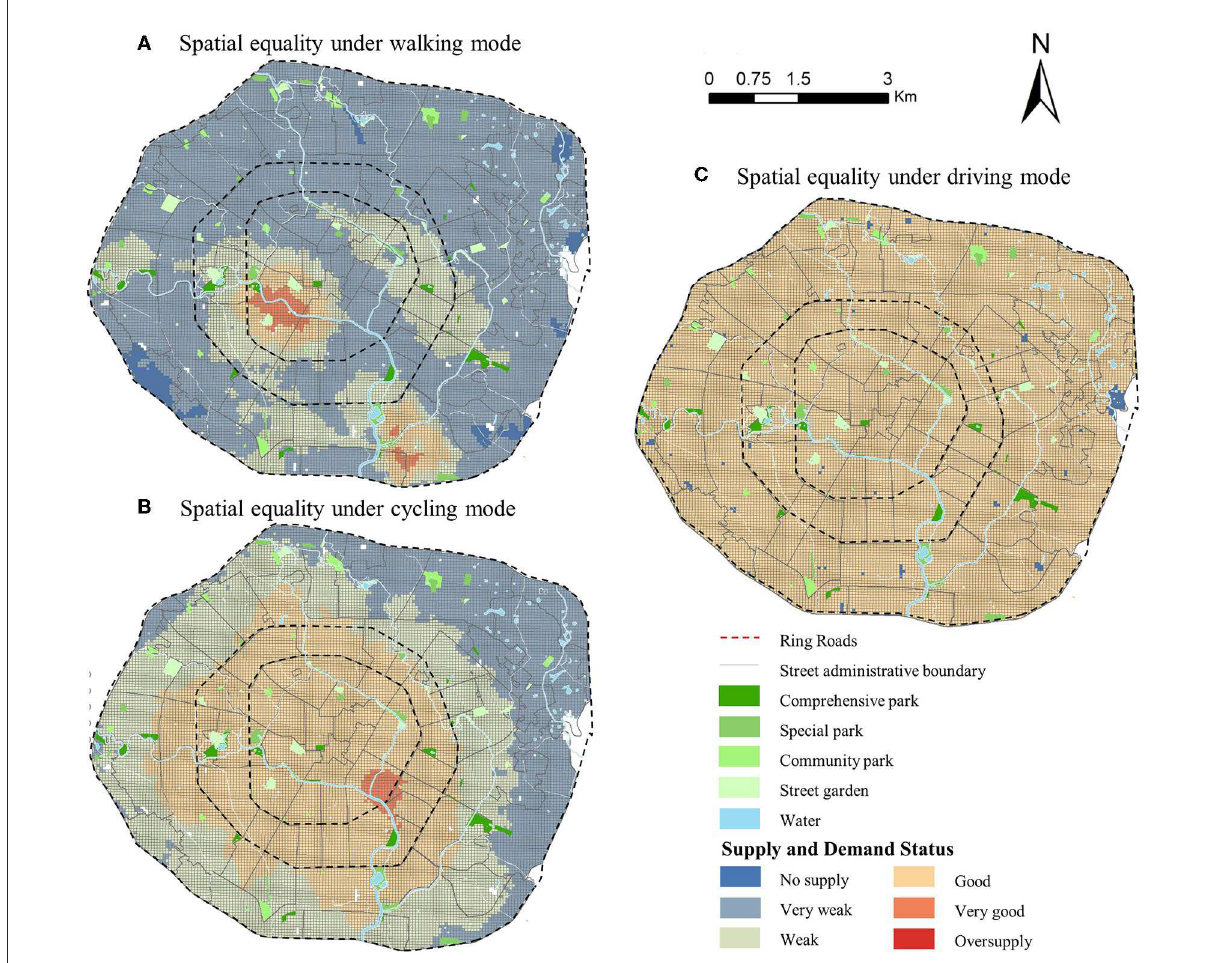
FIGURE9 Spatial equality distribution under different travel modes in Chengdu,